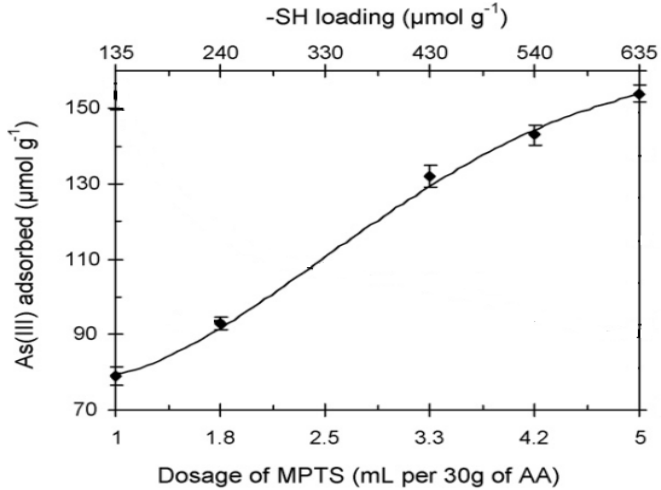
Figure 8. Removal of As(III) as function of -SH loading in the suspensions containing 1.0 equilibrium time = 38 h (after